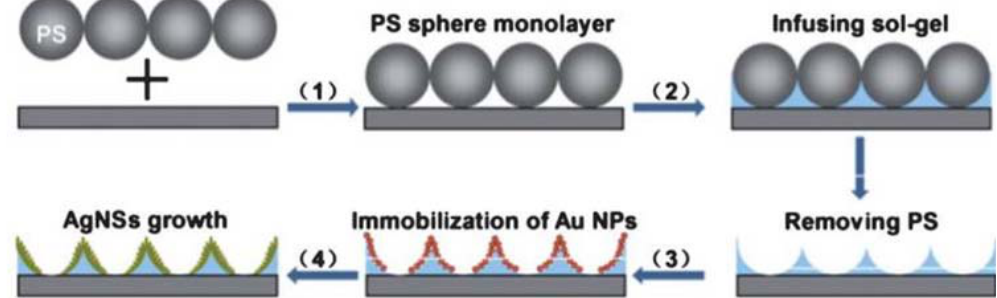
Fig. 12: A schematic illustration of the fabrication process of a 2D Ag nanosheet coated inverse opal film. Reproduced with permission from ref.45, copyright 2012, Royal Society of